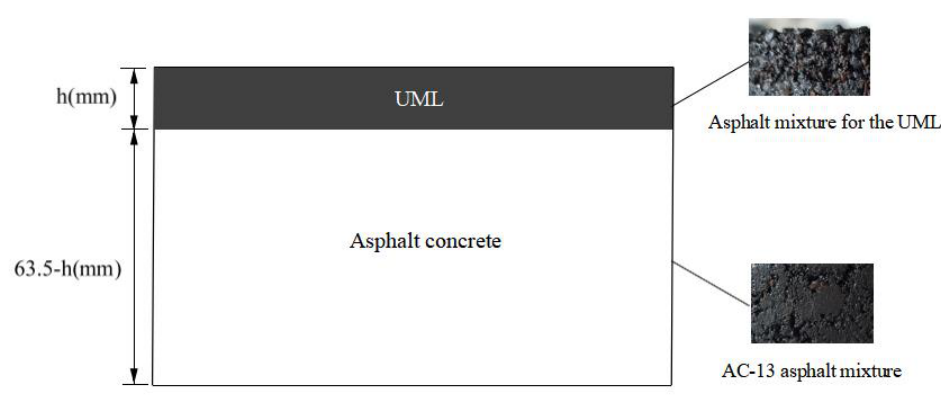
Figure 2. Structure of the low-temperature splitting test specimens.